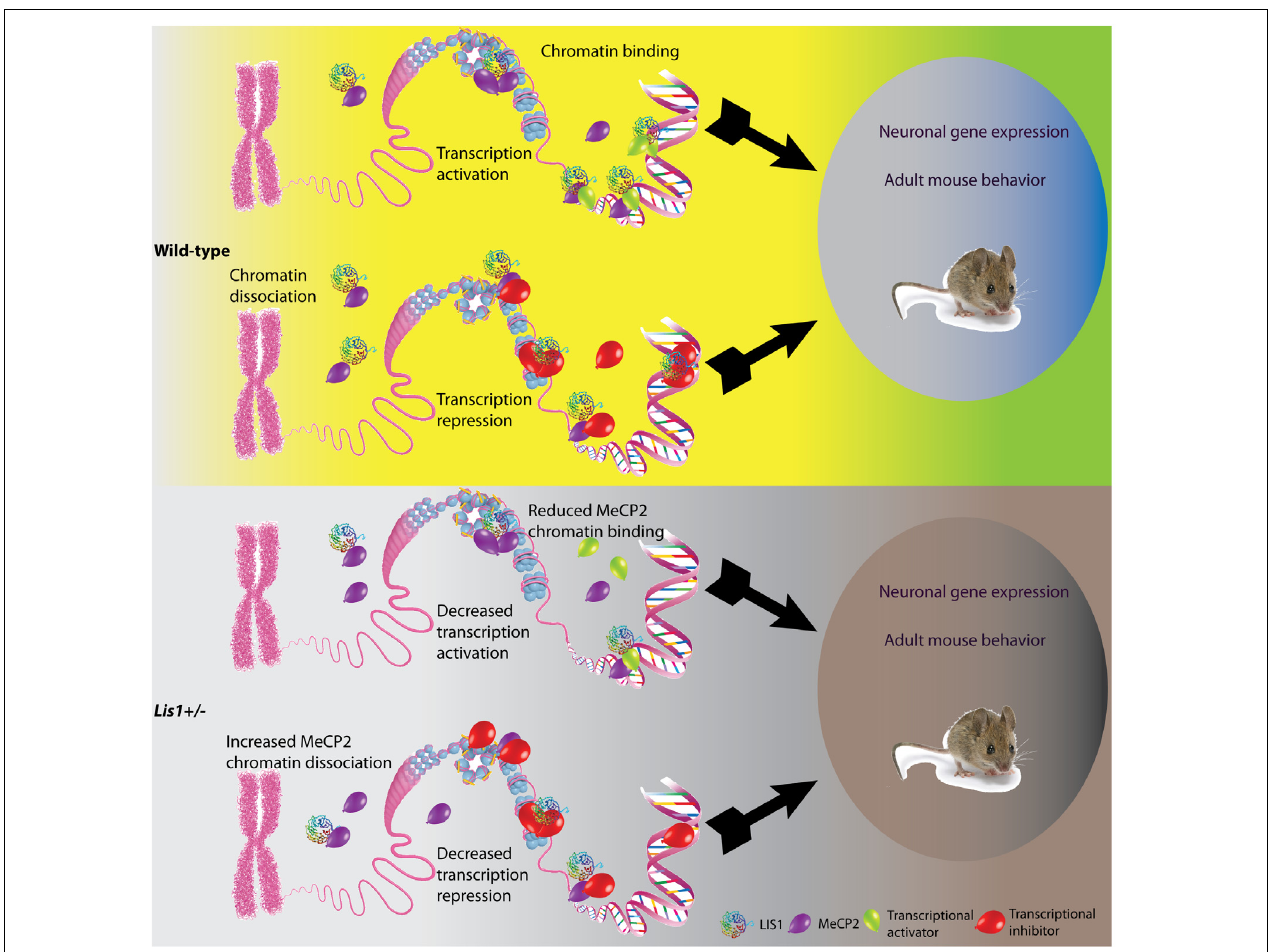
FIGURE 4 | Schematic model illustrating the possible outcomes of LIS1-MeCP2 interaction in the context of wild-type or Lis1 ± . LIS1, shown as a rainbow colored beta-propeller protein, MeCP2, shown as purple balloons, transcriptional activators and inhibitors (green and red balloons, respectively on the bottom), interact in the nucleoplasm, or in close vicinity to the DNA. Transcriptional activation or repression will result in changes in neuronal gene expression as well as adult mouse behavior. (Top) In the wild-type context, LIS1 can either bind to MeCP2 in close vicinity to the DNA, and either recruit transcriptional activators, or assist in MeCP2 binding to chromatin. In addition, LIS1 may bind to MeCP2 in the nucleoplasm. These interactions will result in transcriptional activation. In other loci, LIS1 can bind to MeCP2 in close vicinity to the DNA in association with transcriptional repressors, alternatively LIS1 may aid in recruitment of transcriptional repressors to MeCP2. An additional option may be that LIS1 interacts directly with transcriptional repressors and enhances their activity. These interactions will result in transcription repression. (Bottom) In the context of Lis1 ± , we can observe reduced LIS1 levels. The effect of LIS1 reduction will be dependent upon the affinity of the different protein interactions. In case of transcription activation, we expect that less LIS1 will be found in association with MeCP2 and transcriptional activators thus resulting in decreased transcription activation. In case of transcription repression, less LIS1 may results in increased levels of MeCP2 in the nucleoplasm and less in association with